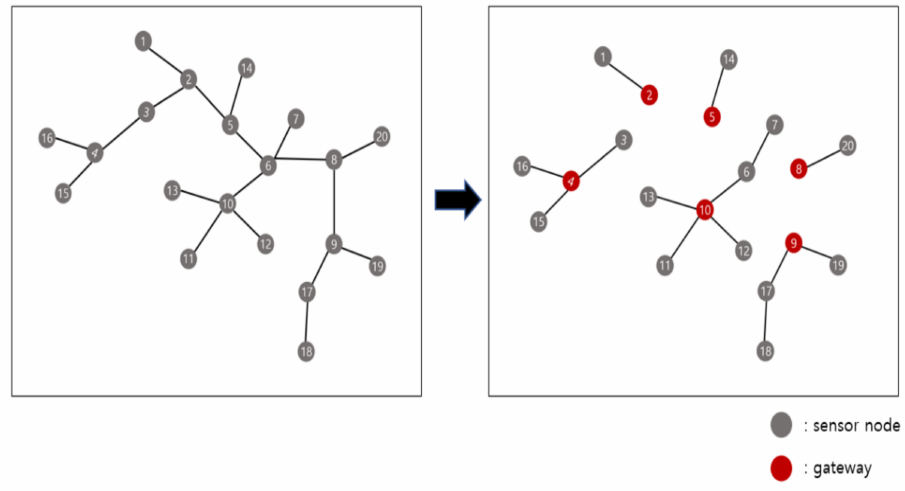
Figure 8. Example for 20 sensor